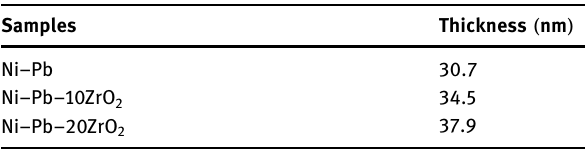
Table 3: The thickness of layer